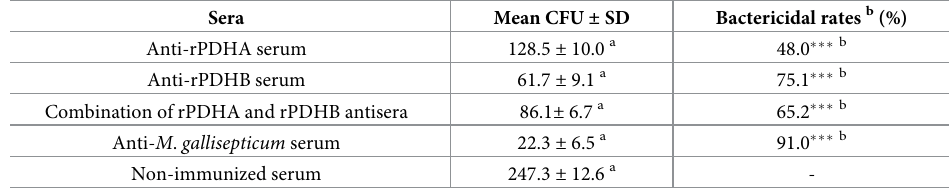
Table 2. Bactericidal rates of mouse antisera against rPDHA or rPDHB.